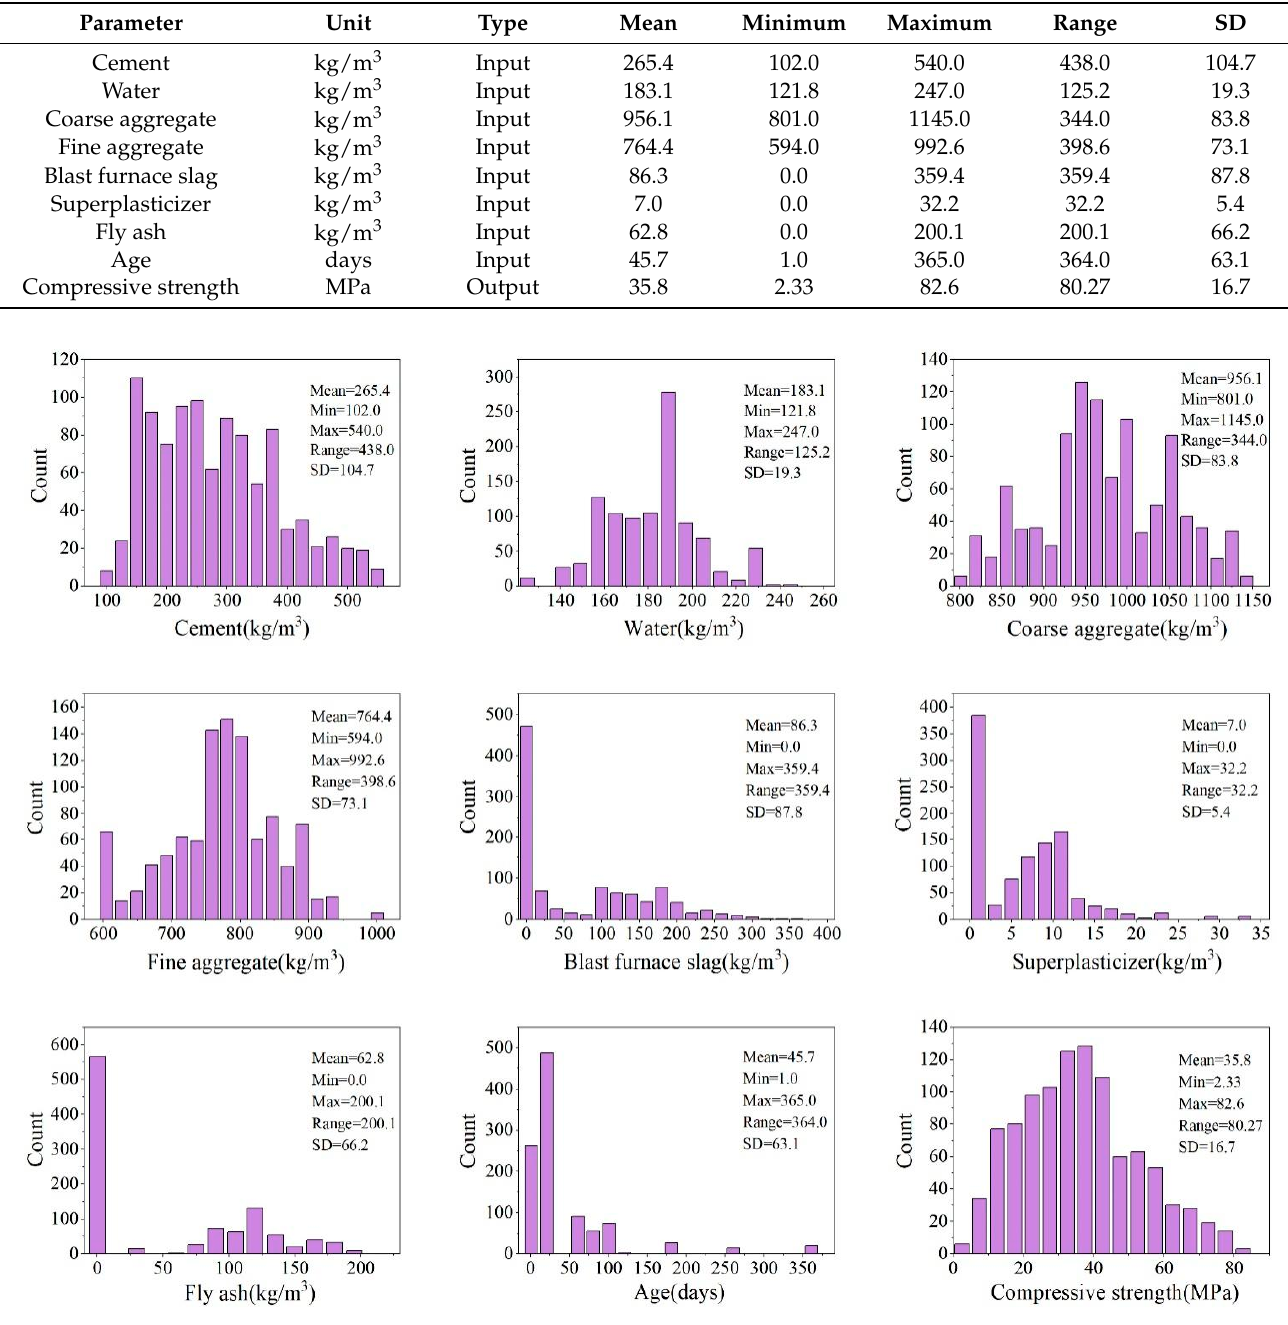
Figure 4. Histogram statistics for input and output variables. Table 1. The statistical analysis in the compressive strength tests.